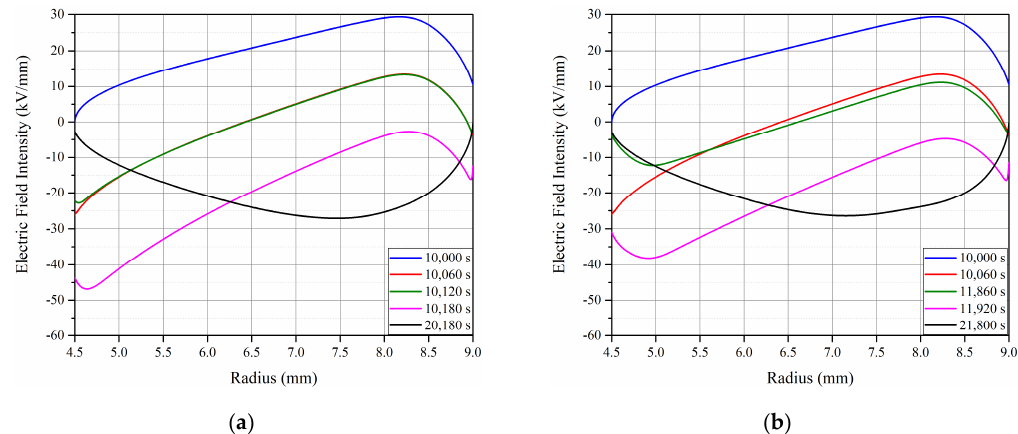
Figure 18. Time-varying electric field distribution after polarity reversal at 350 A: ( a ) Potential zero duration 60 s; ( b ) 1800 s. Table 3. Intensity and location of maximum electric field under simulation conditions.